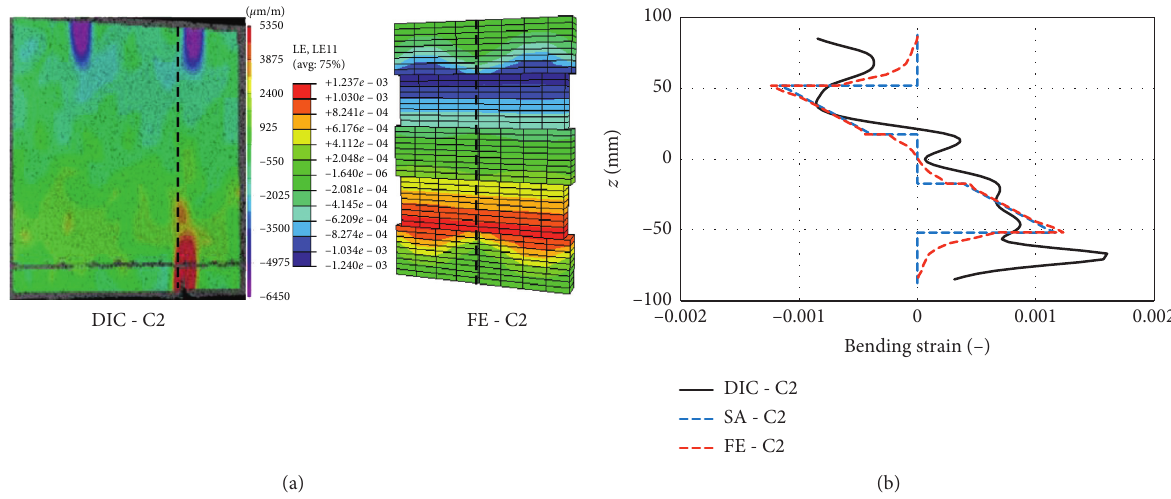
Figure 21: Colour contour plots and normal strain distribution from bending tests for